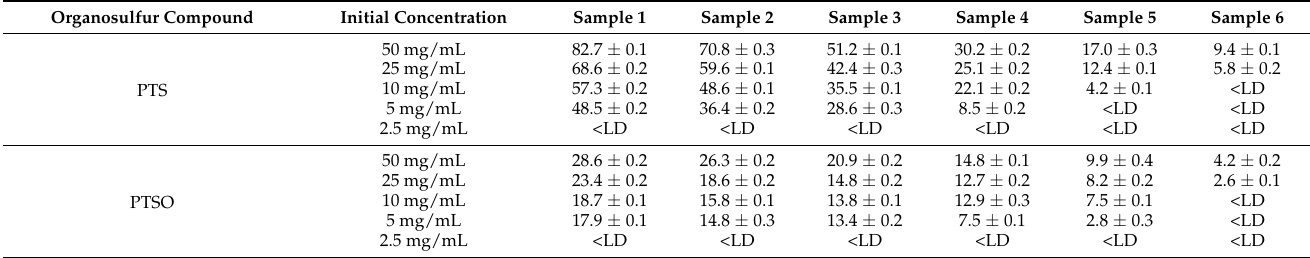
Table 3. Concentration ± standard deviation (in mg/L) of PTS and PTSO reached in Mueller–Hinton agar for each of the samples, in relation to the initial concentration of each substance in the drop deposited on the lid of the Petri dish.